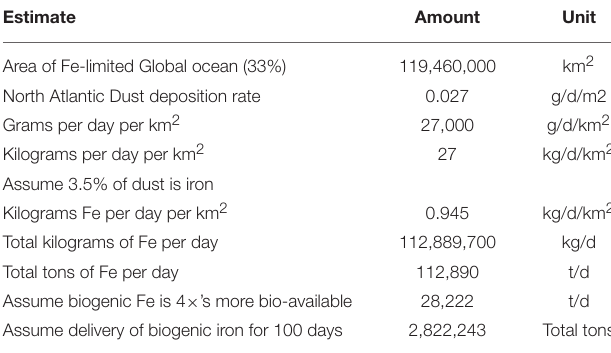
TABLE 1 | Estimate of iron requirement for annual OIF of one-third of the open ocean, based on total global ocean area of 361,900,000 km 2 (source, NOAA). Estimate